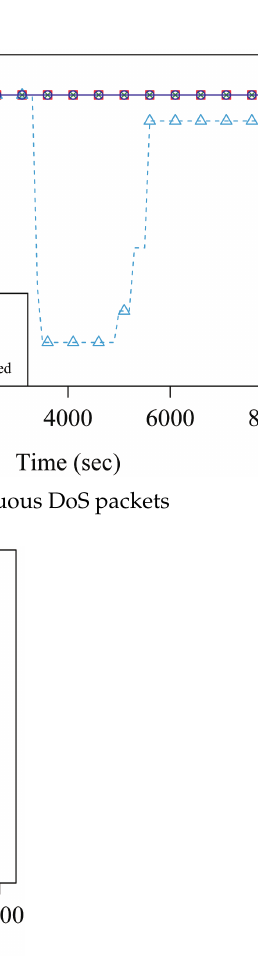
Figure 5. Scenario 3: one-pulse DoS packets. ( a ) packets (count); ( b ) response time; ( c ) number of VMs.